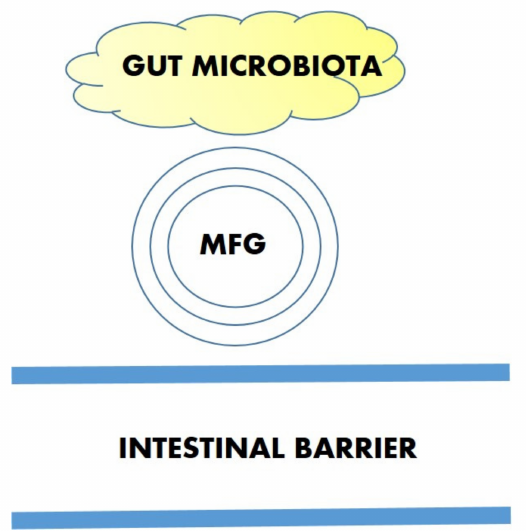
Figure 1. Schematic representation of the molecular–structural interplay in MFG with the tripartite membrane, intestinal barrier, and gut microbiota. This is a schematic representation; the dimensions are not in scale, but it is useful to highlight the MFGM platform role for assuring interplay among different